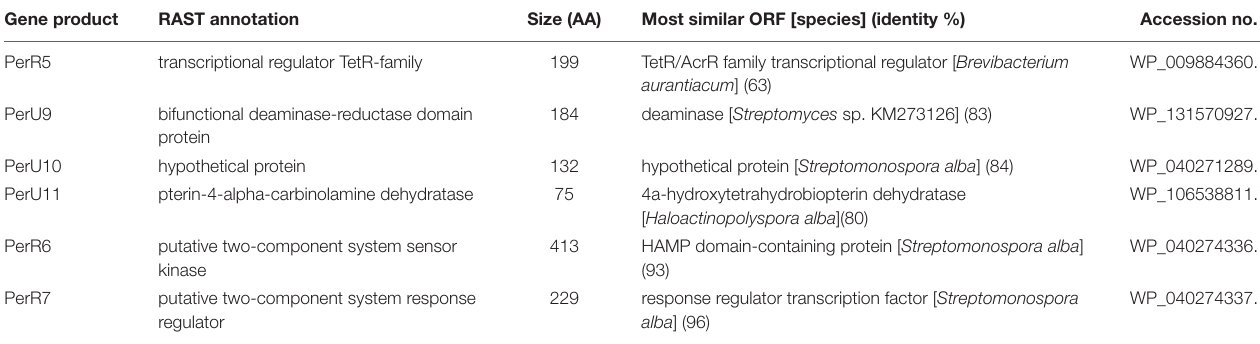
( Figure 2 ) and weak potency (IC 50 : 715 µ M) against